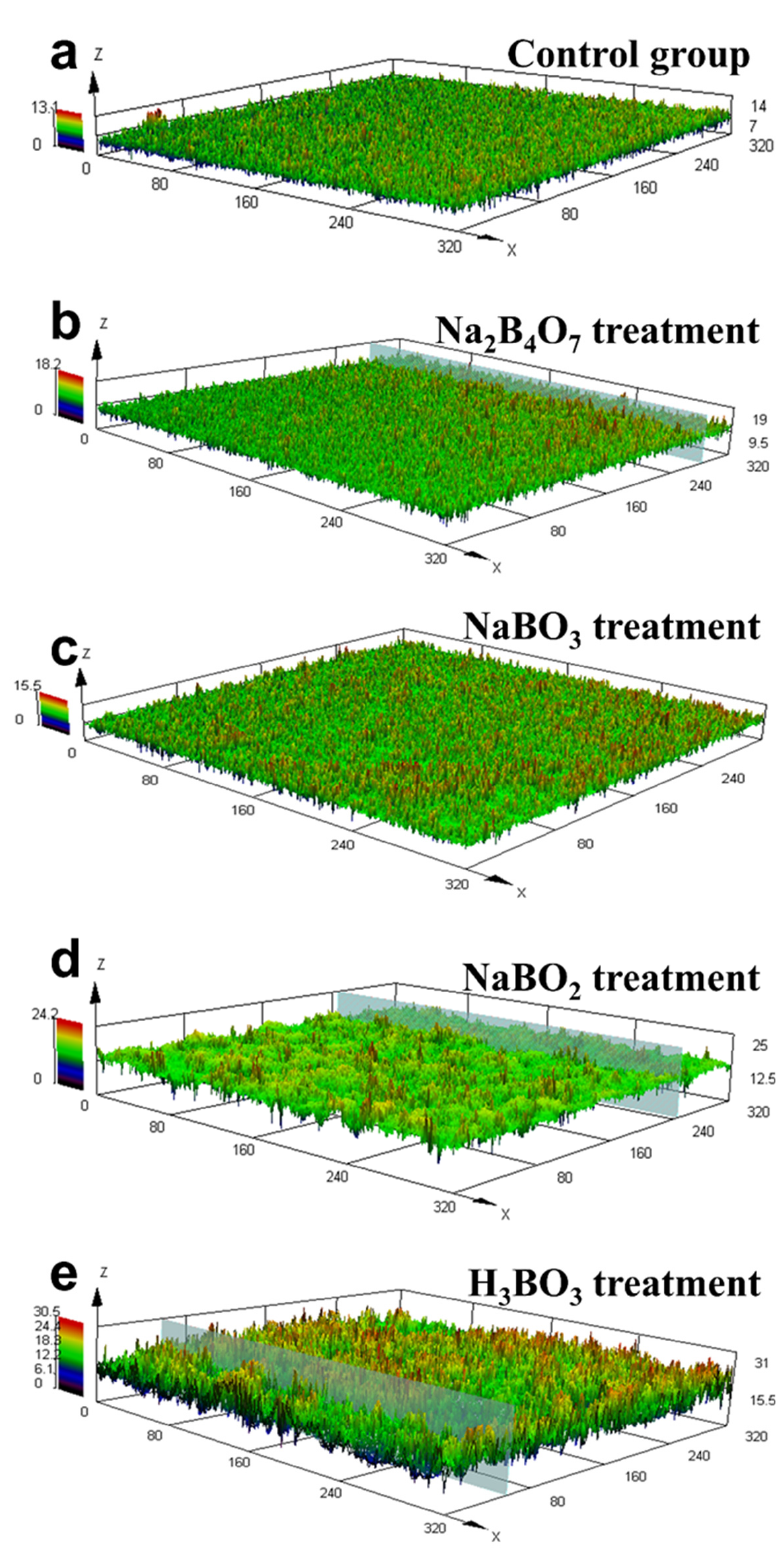
Figure 4. CLSM diagrams of biofilms cultured with no boron derivatives ( a ), Na 2 B 4 O 7 ( b ), NaBO 3 ( c ), NaBO 2 ( d ), and H 3 BO 3 ( e ) treatment. The concentration of all boron derivatives was 0.6 mM, and the incubation time was 12 h. X and Y axes represent the length of the 3D map of the biofilm, and Z-axis is the thickness of biofilms ( μ m).